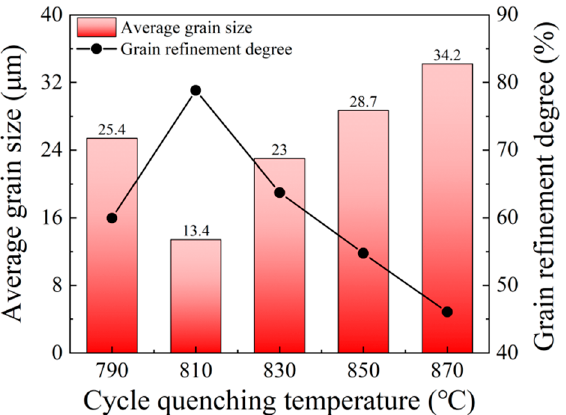
Figure 9. Variations in average grain size and grain refinement degree with cyclic quenching temperature.